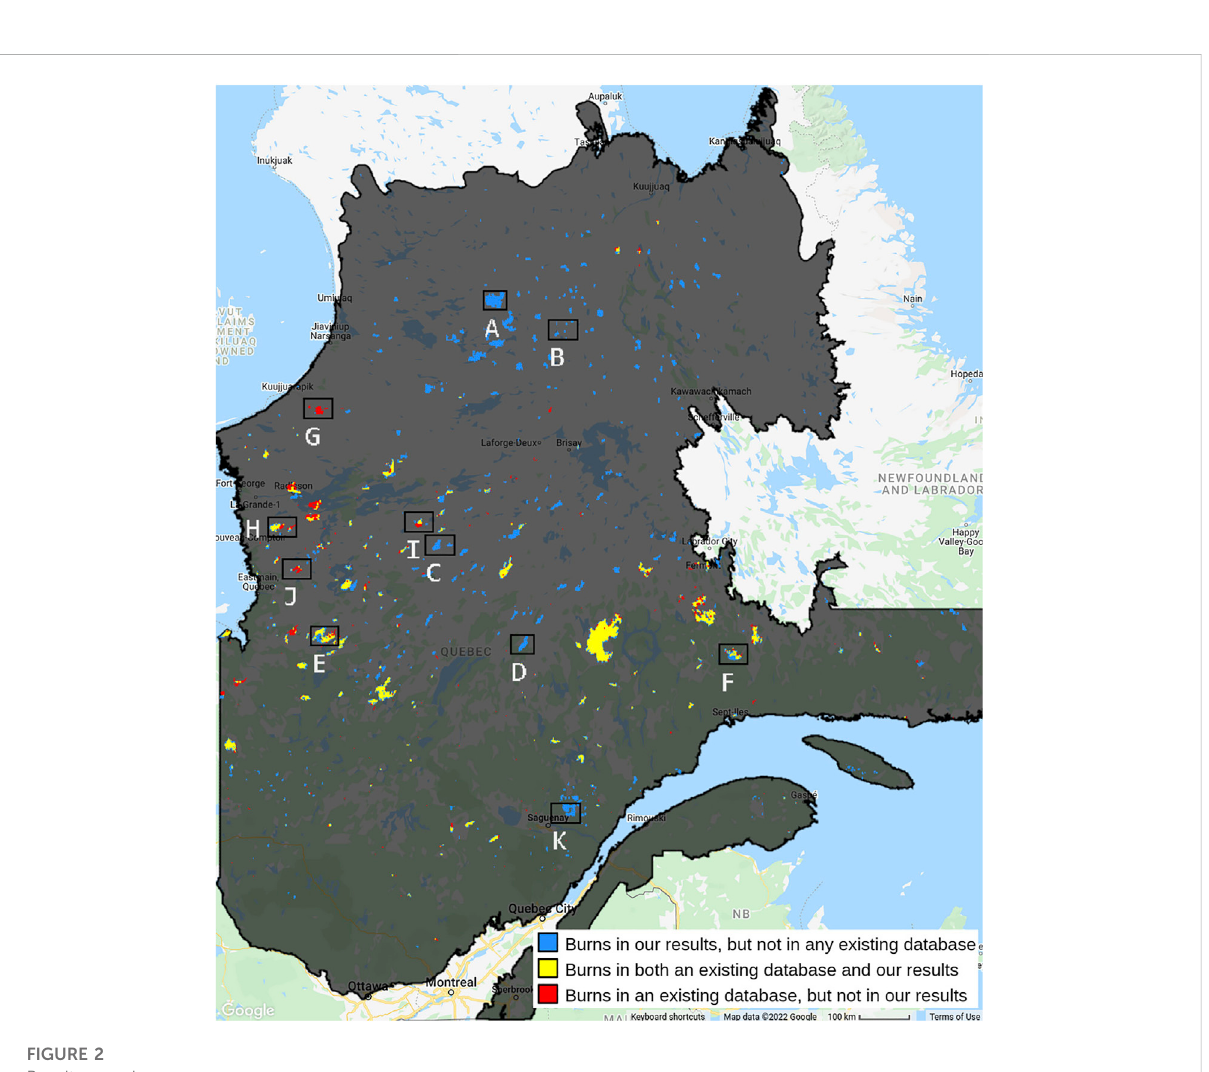
FIGURE 2 Results